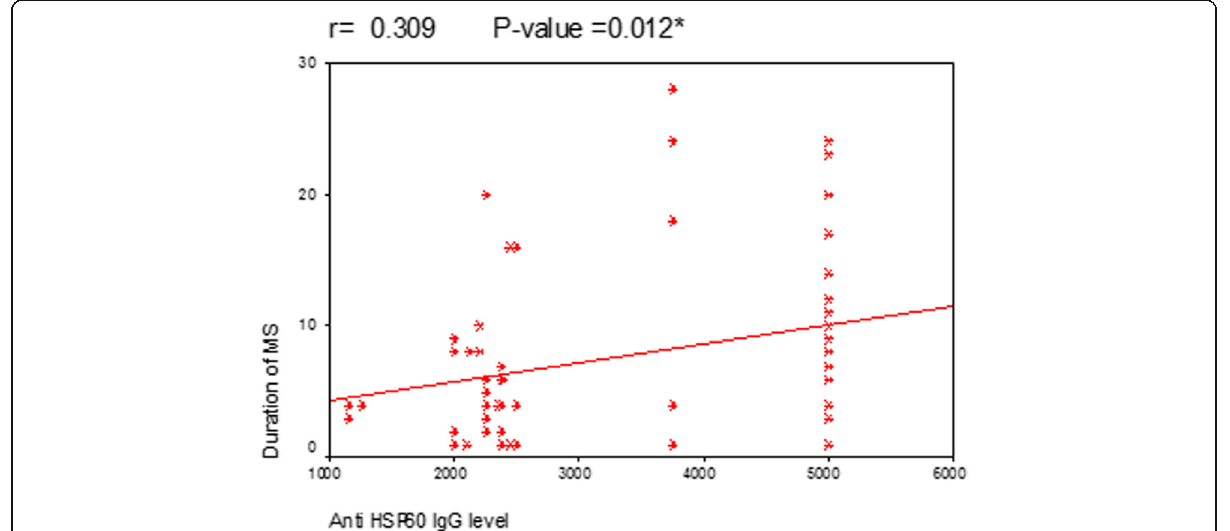
Fig. 2 Correlation between anti Hp hsp60 IgG level and duration of